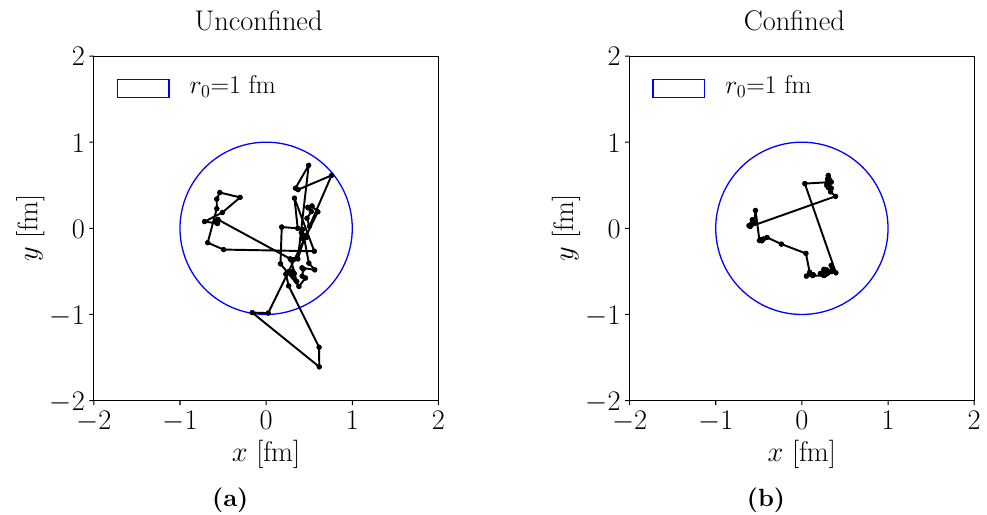
Figure 5. An initial state proton consisting of three dipoles in an equilateral triangle con(cid:12)guration after a full evolution at 7 TeV (corresponding to y max = 8 : 86). (a) has been evolved without con(cid:12)nement, while (b) has been evolved with con(cid:12)nement. The parameters of table 1 have also been applied in this